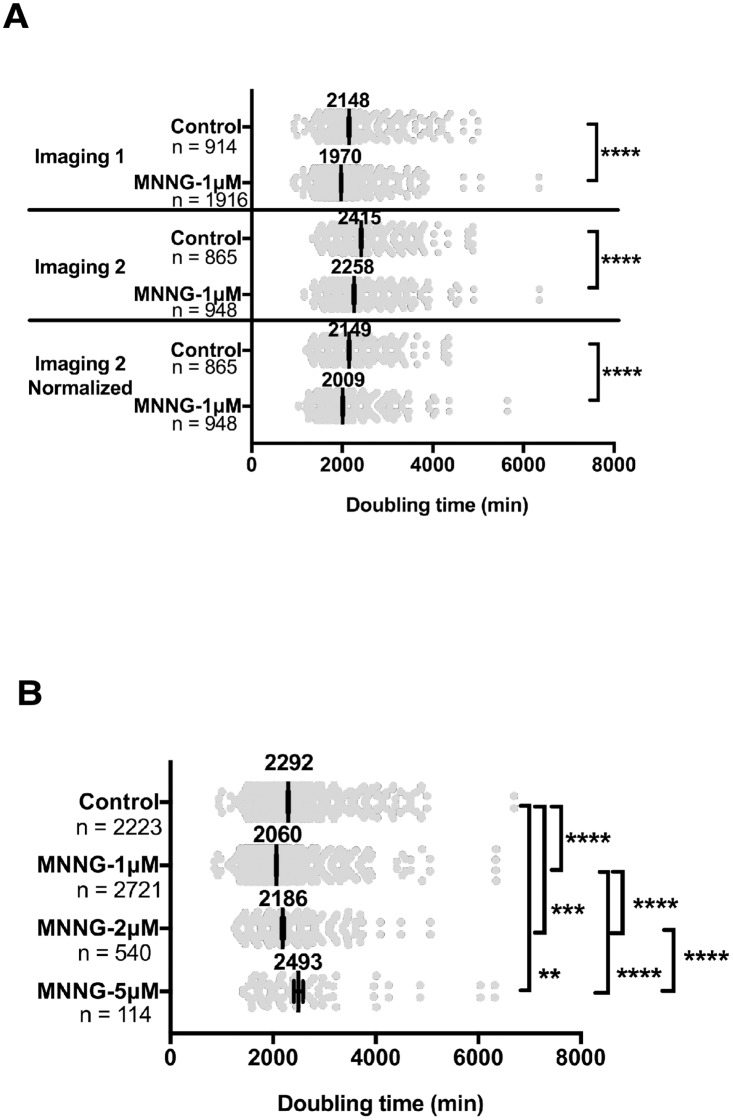
Analysis of cell-doubling time.A. Two sets of videos for Control and MNNG-1μM-exposed cells were created by independent long-term live cell imaging and used for cell tracking analysis (Imaging 1 and 2). Cell doubling times analyzed by Imaging 2 were normalized by a factor of 1.124 (Imaging 2, Normalized). Welch’s t-tests were performed to analyze the statistical significance between Control and MNNG-1μM; ****p<0.0001. Results shown as the mean ± standard error (SEM). B. A cell lineage database was created by merging multiple cell lineage databases. Cell doubling times were analyzed for Control, MNNG-1μM-, MNNG-2μM-, and MNNG-5μM-exposed cells. One-way ANOVA (Tukey’s multiple comparison test) was performed; **p<0.01, ***p<0.001 and ****p<0.0001.